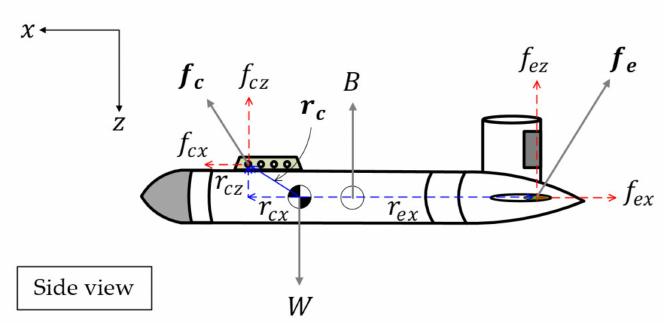
Figure 5. Forces acting on towfish in x − z plane (vertical plane).